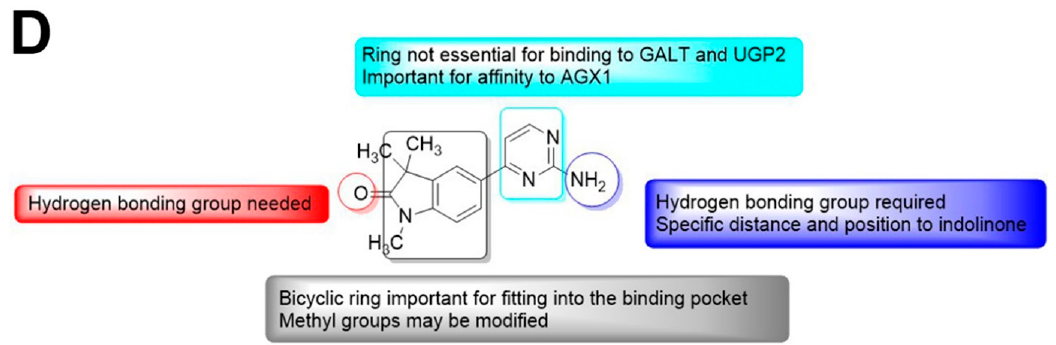
Figure 5. The docking models of GAL-012-2 binding to the three UDP-hexose pyrophosphorylases and Preliminary SAR analysis of GAL-012 series. Docking of GAL-012-2 to ( A ) GALT, ( B ) UGP2, and ( C ) AGX1/UAP1 were performed using Glide (Schrödinger, LLC). ( D ) SAR analysis results based on the relative activities of different analogues against the respective UDP-hexose pyrophosphorylases.